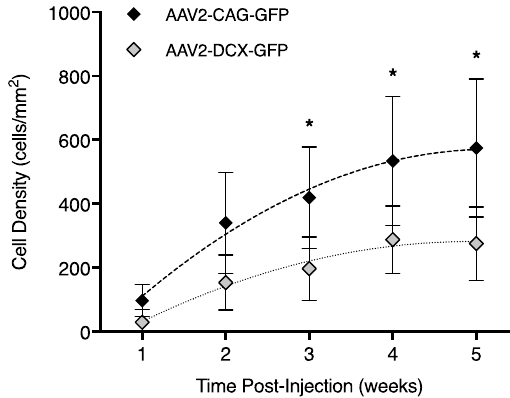
Figure 2. Comparison of in vivo GFP expression in the ganglion cell layer between vectors after intravitreal injection. Cell densities were calculated from 30-degree field of view (approximately 1.36 mm) fluorescence confocal scanning laser ophthalmoscopy images centred at the optic nerve head for the AAV2-CAG and AAV2- DCX vectors. Trendlines show the second-order polynomial regression results calculated for each group. Error bars represent 95% confidence intervals; * p < 0.05; n = 6.